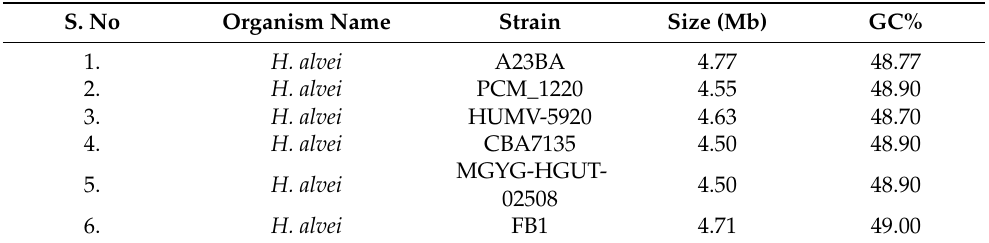
Table 1. Different statistics of H. alvei strains available at NCBI genome database. Only complete sequenced strains are presented